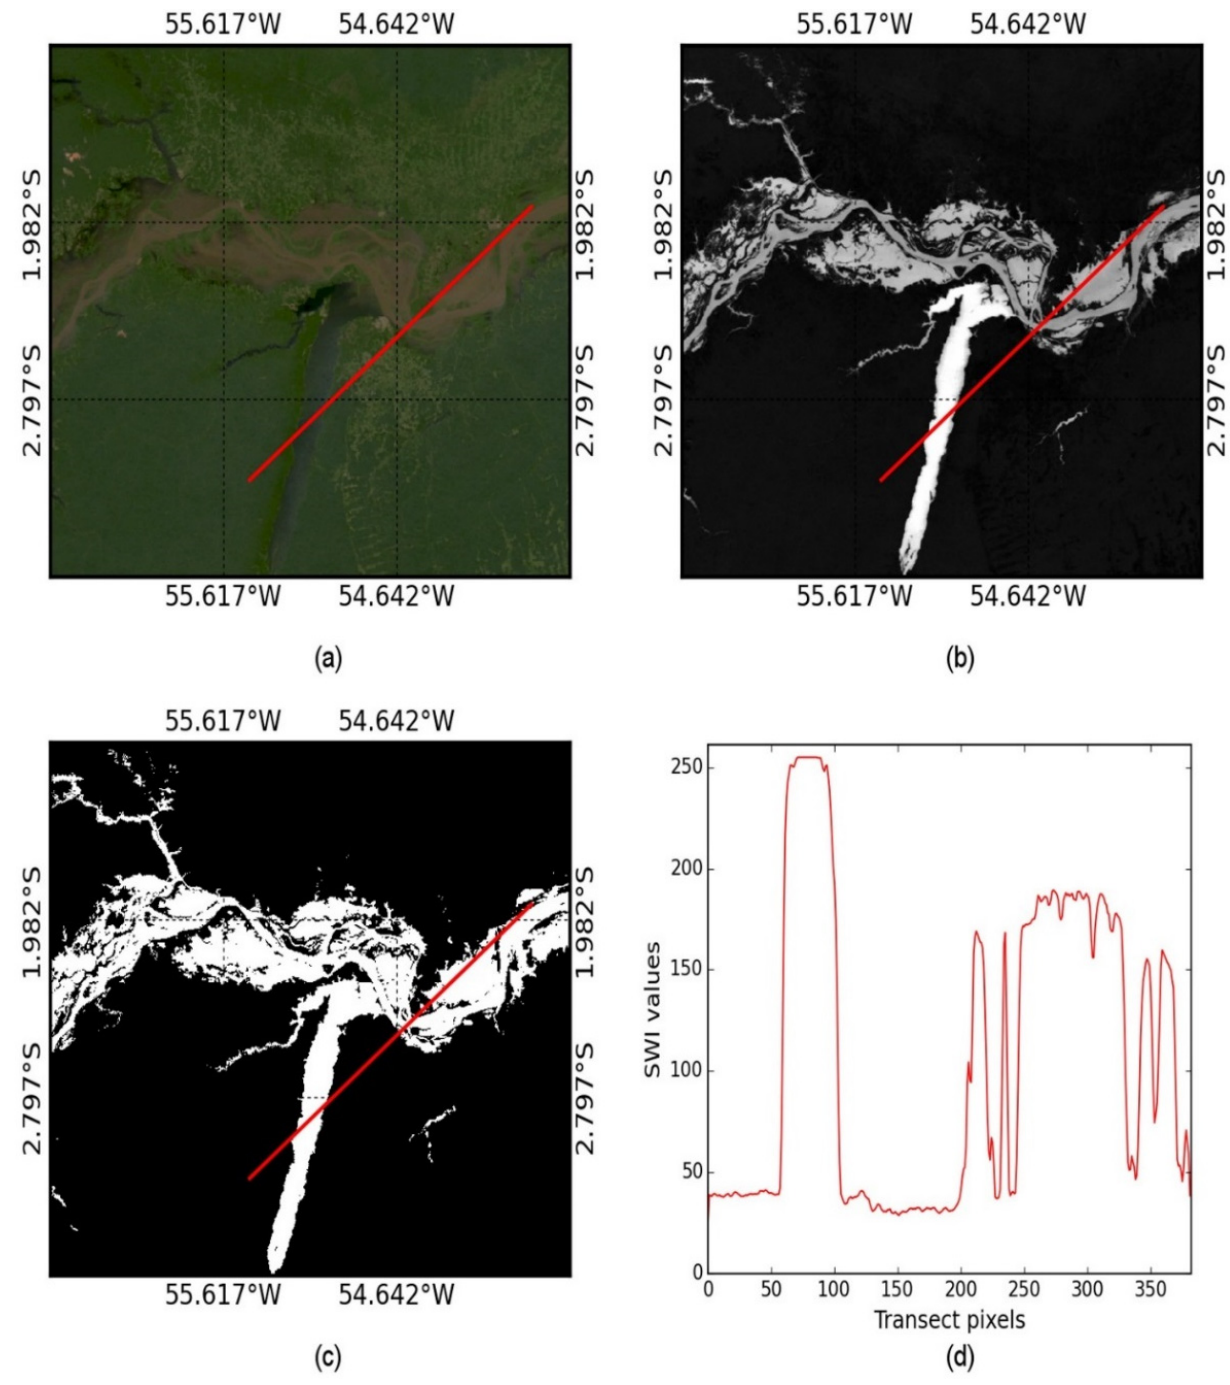
Figure 18. Performance of SWI based extraction of water cover in case of dark vegetation with varied turbidity of water bodies: ( a ) MODIS true-color image, ( b ) SWI image, ( c ) Extracted water cover, ( d ) Profile plot of SWI along the red line